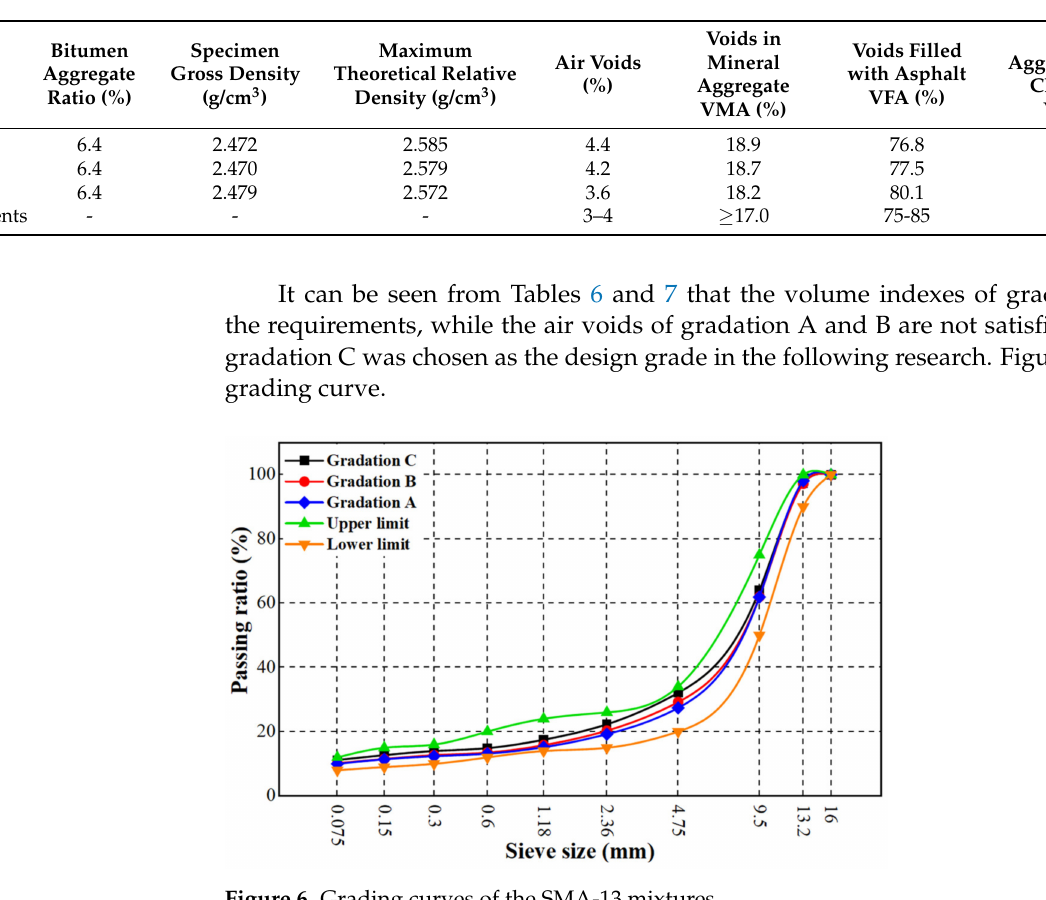
Table 7. Gradation volume analysis.